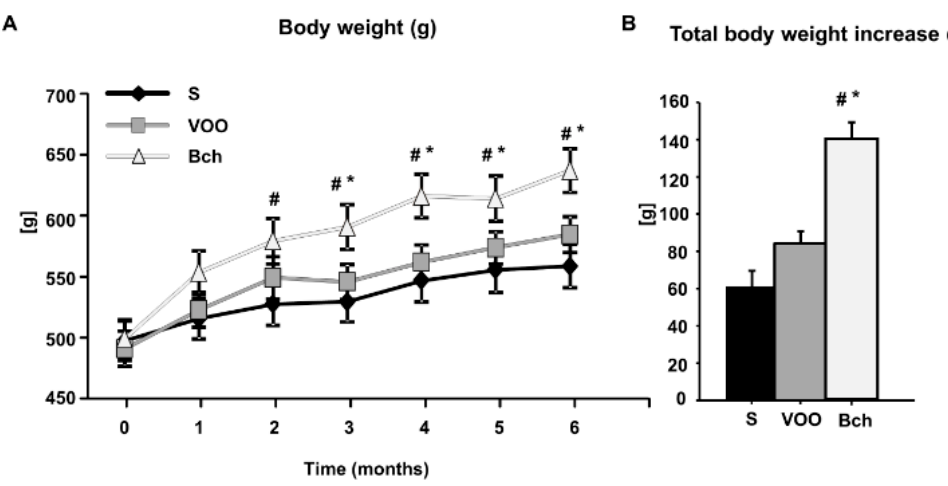
Figure 1. ( A ) Values represent mean ± SEM of body weight (g) in a serial time analysis, during the 6 months of the experimental period: from 0 (6 months-old) to 6 (12 months-old) in animals fed standard (S), virgin olive oil (VOO) and butter plus cholesterol (Bch) diets. ( B ) Mean ± SEM values of body weight increase (g) in S, VOO and Bch. * ( p < 0.05) differences vs. standard diet, # ( p < 0.05) differences vs. virgin olive oil diet.